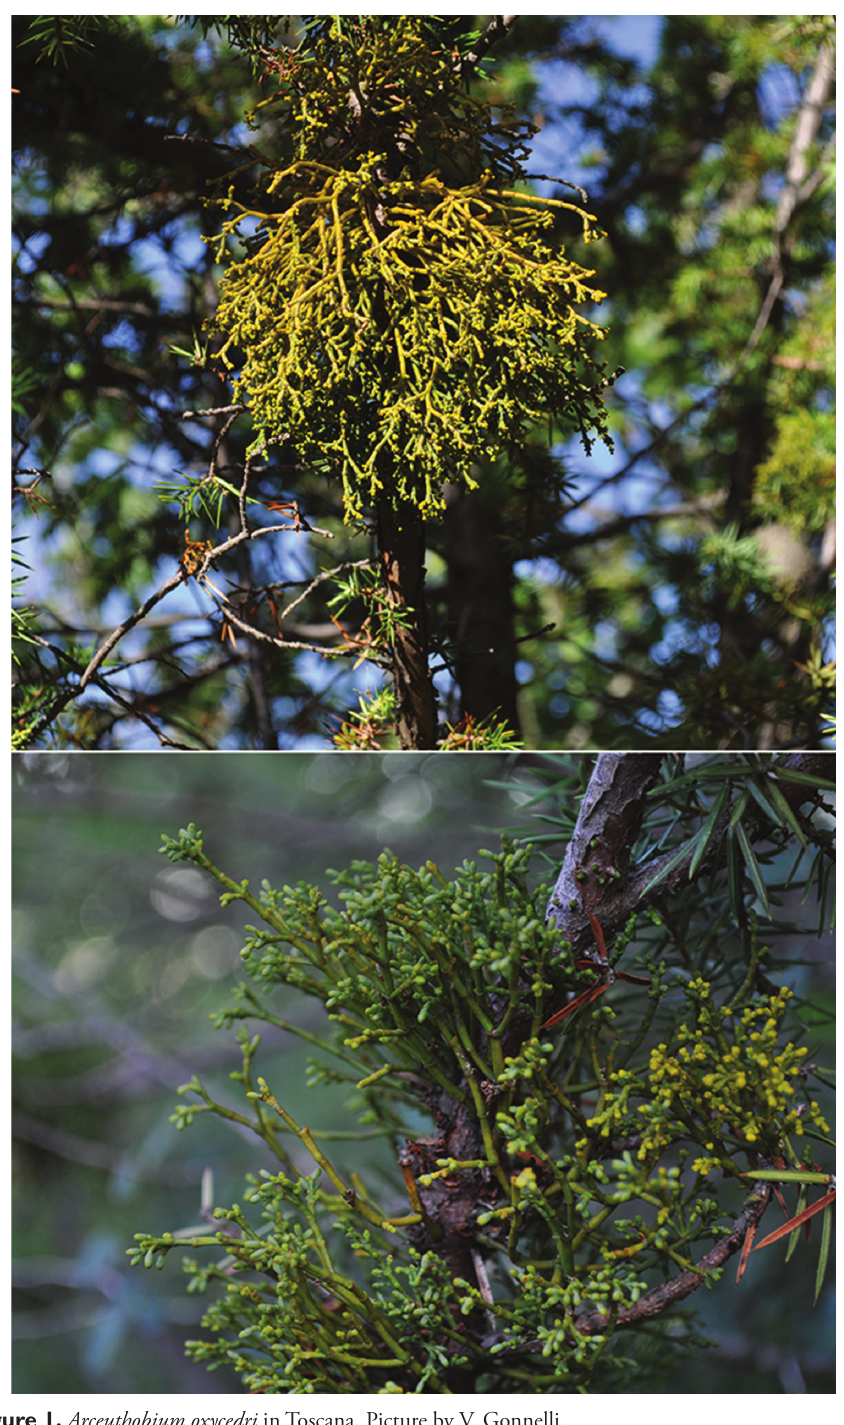
Figure 1. Arceuthobium oxycedri in Toscana. Picture by V.